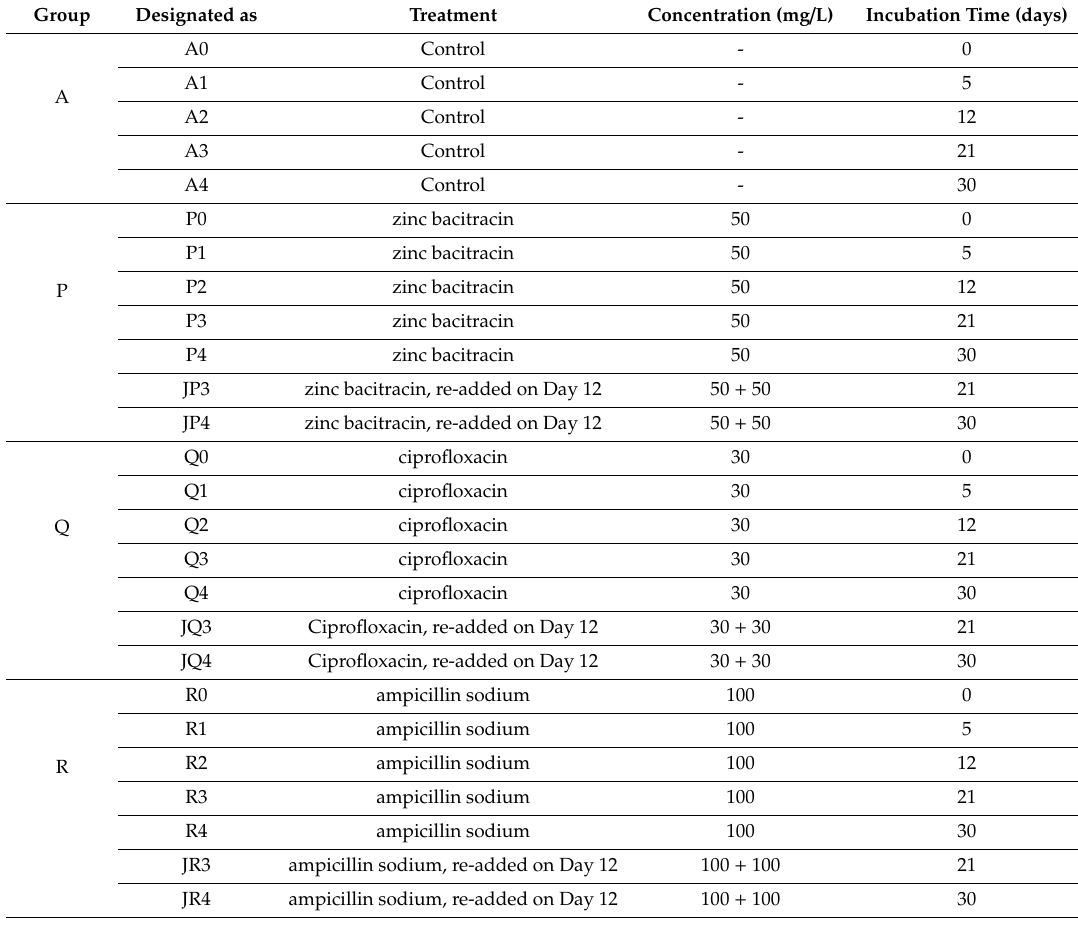
Table 1. Details of experimental